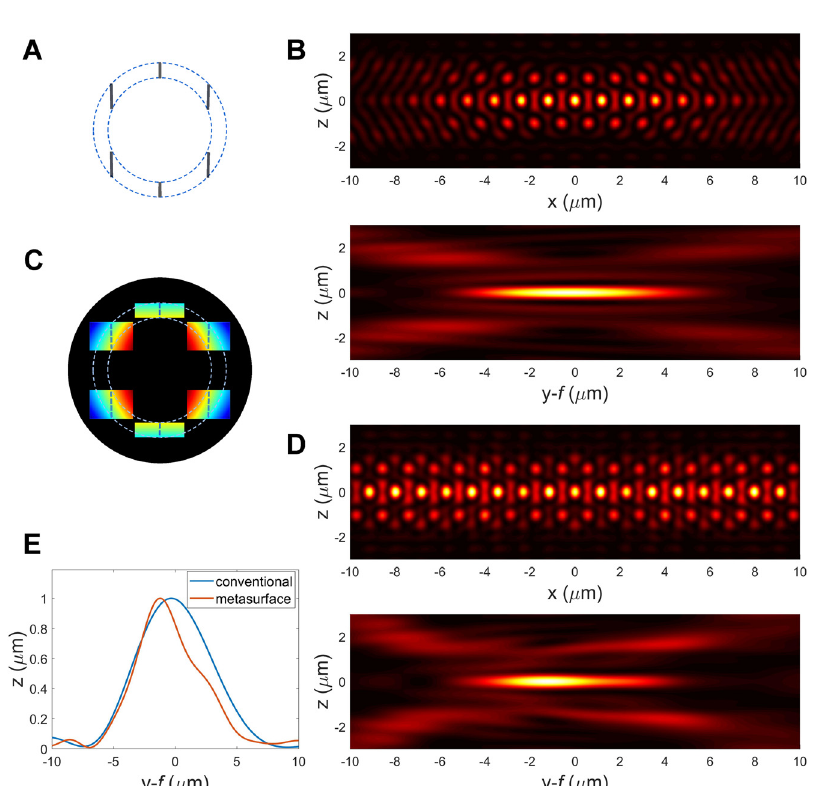
Figure 4: (A) Schematic view of the diffracted light waves from the metasurface blocks with spatial phase profiles in (B). (B) Spatial phaseprofilesofthemetasurfaceblocksare defined by Equation (6). (C) Simulated xz and yz cross-sectional intensity distribution of the produced square lattice